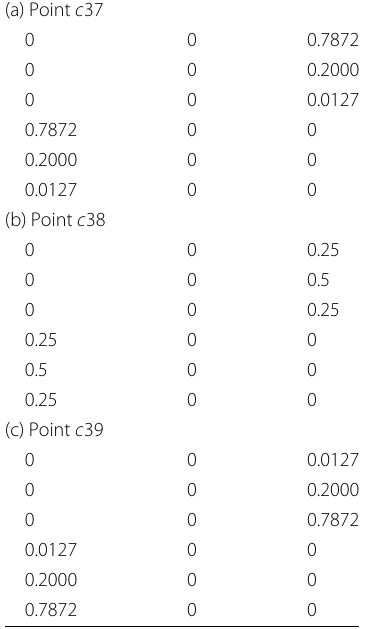
Table 3 Example two-patch model: shape function values N i ( ξ , η ) for the integration points c 37 − 39 for the master side (nodes 1–9, upper values) and slave side (nodes 10–18, values